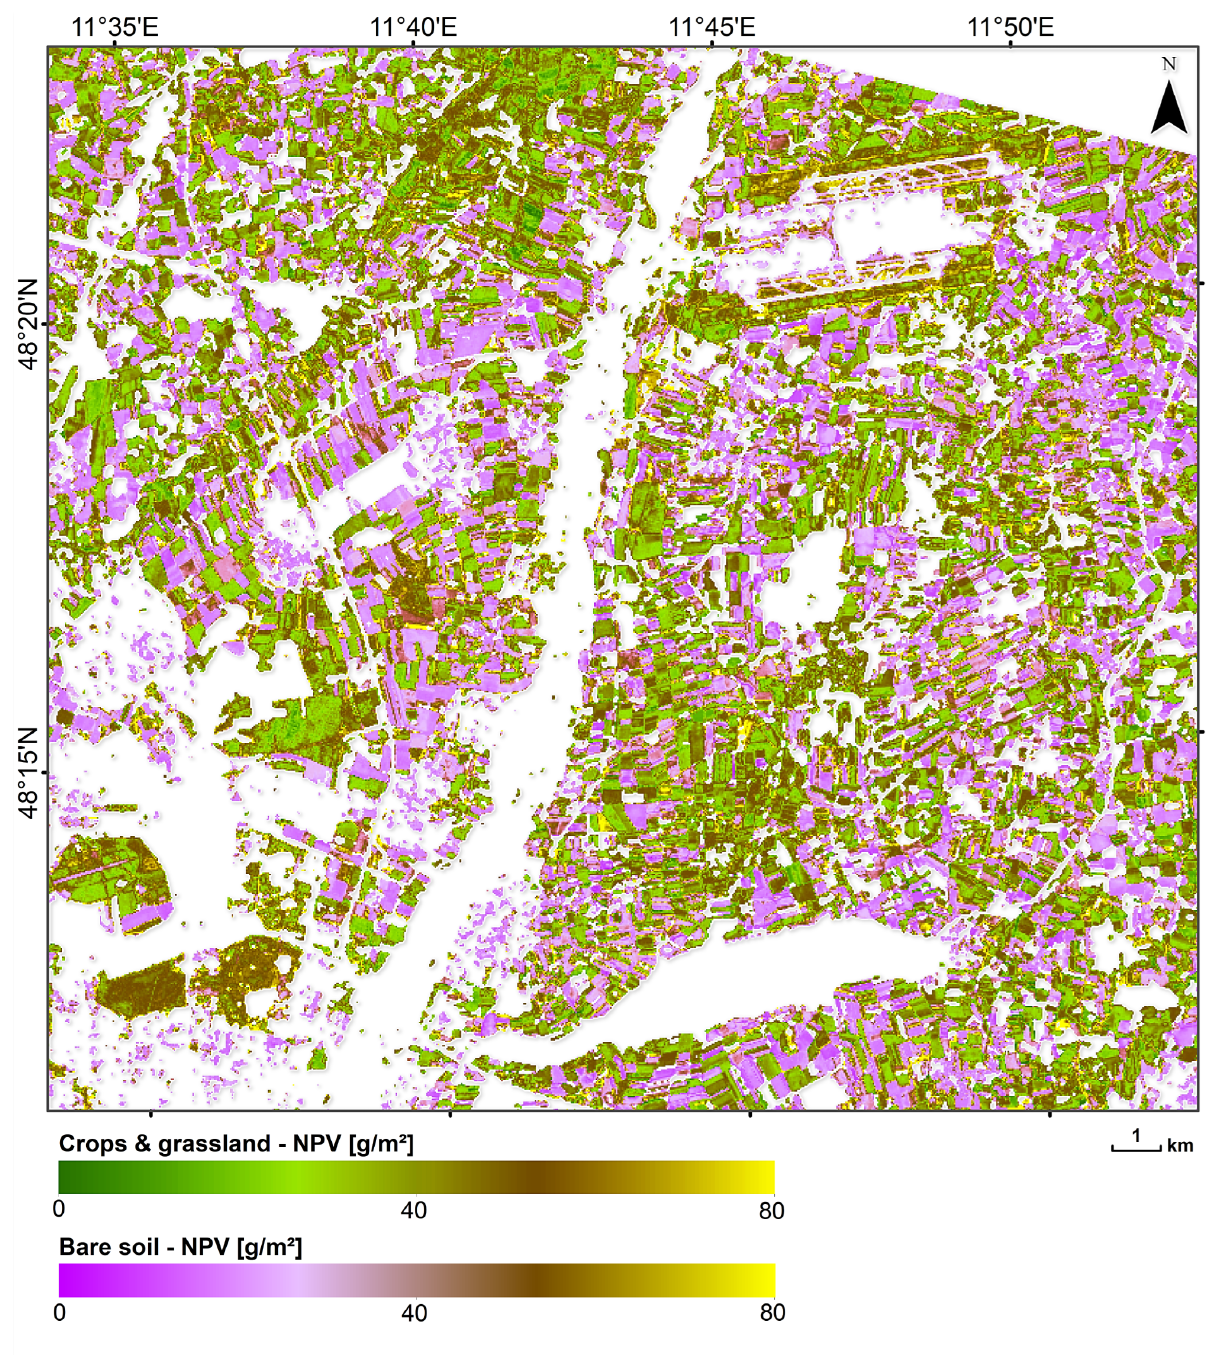
Figure 8. Mapping of non-photosynthetic cropland/NPV biomass using the full PRISMA scene covering the North of Munich, Germany. Based on image classification, only crops and grasslands, as well as bare soil areas were mapped; white zones were masked